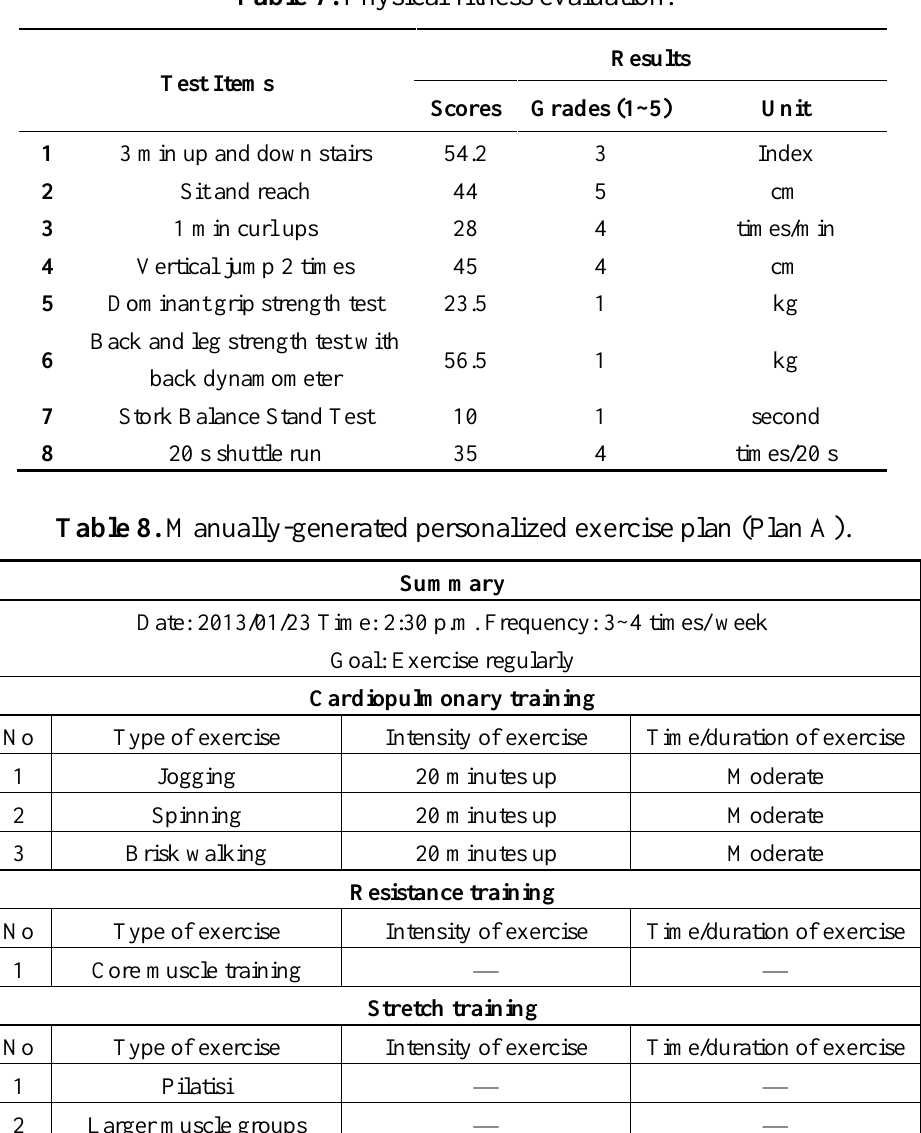
Table 7. Physical fitness evaluation.